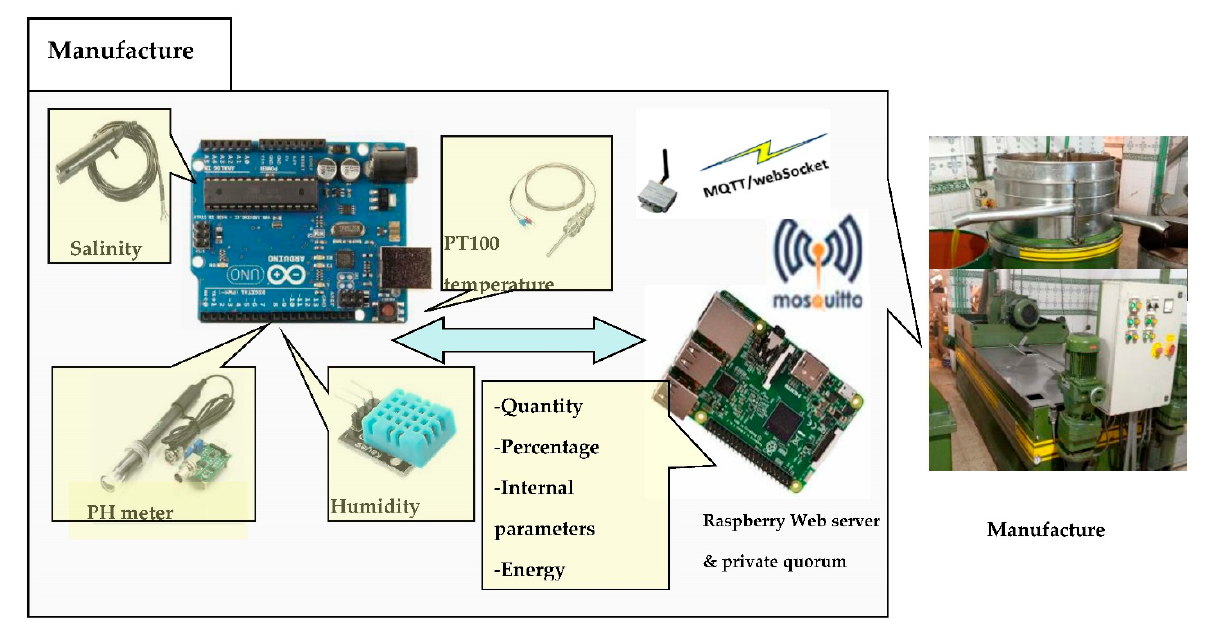
Figure 7. Manufacture platform.